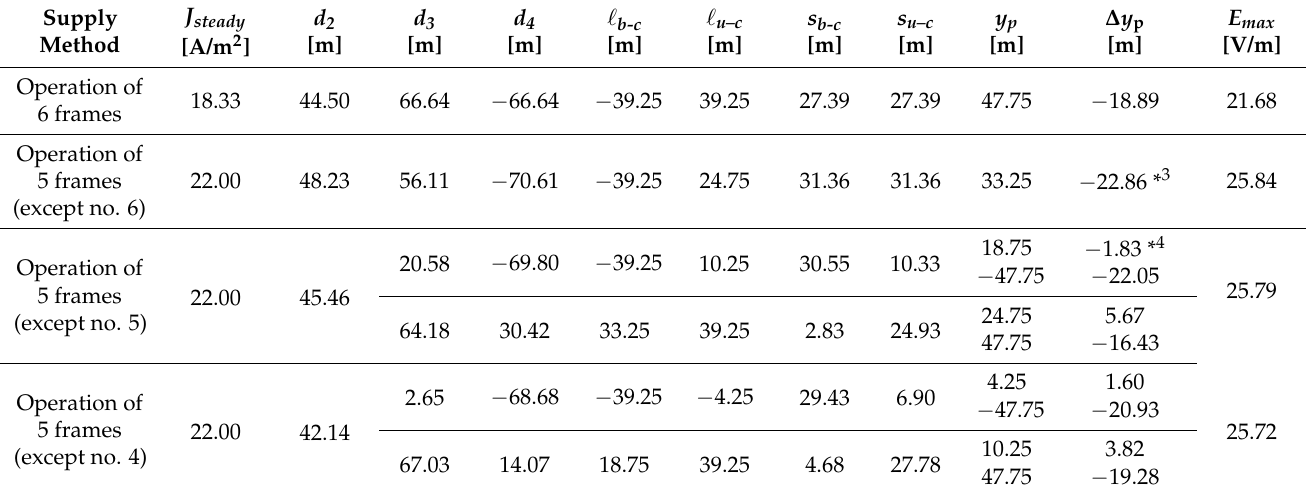
Table 13. Simulation results with method “C”, of a linear current source, for the case of an ar- rangement of 6 linear frames, in a row, each consisting of 13 electrodes, for the area of Korakia, Crete ( ρ S = ∞ , without dam, L = 2.13 m, D el = 0.50 m, d frames = 8.50 m, ρ w = 0.25 Ω · m, θ = 248 ◦ , E limit_S = 1.25